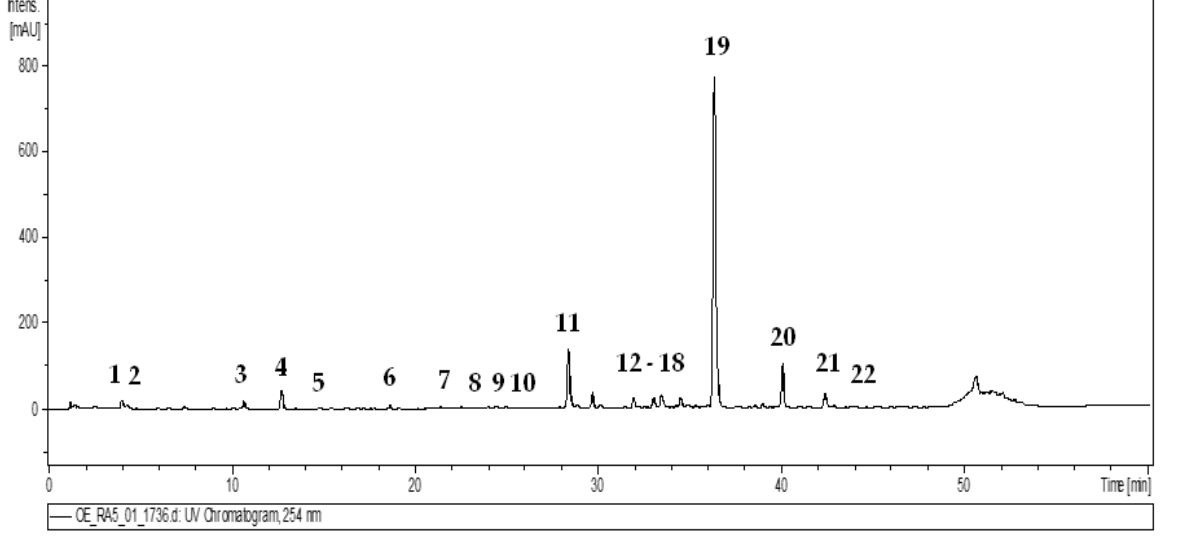
Figure 1. Representative UHPLC-UV chromatogram of the O. europaea leaf extract at 254 nm. The peak numbers refer to those presented in Table 1. Table 1. UHPLC-PDA-ESI-MS 3 data of polyphenols identified in the commercial O. europaea leaf extract.